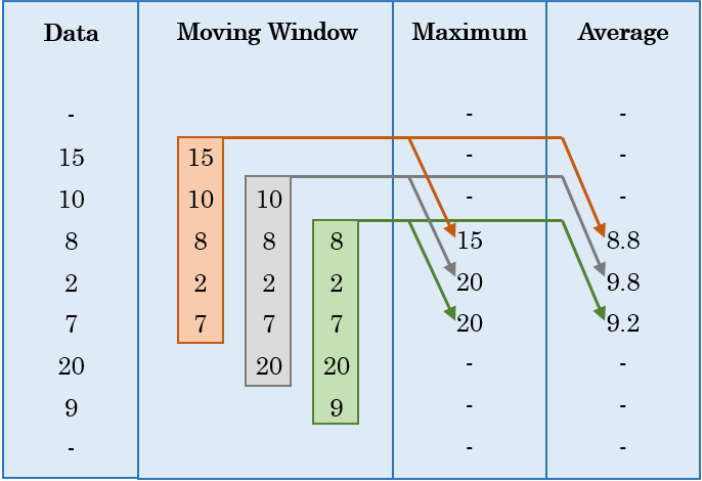
Figure 8. Application of the moving window concept.